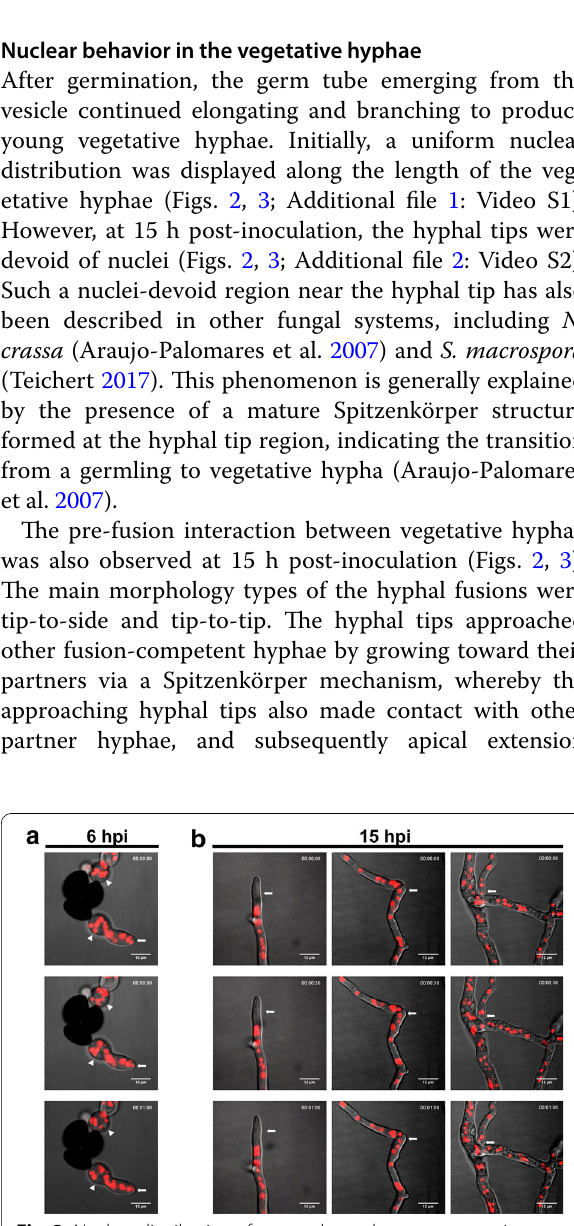
Fig. 3 Nuclear distribution of germ tube and mature vegetative hyphal tip and representative hyphal fusion events. The ascospores of the H2B‑mCherry‑labeled strain were grown on malt extract agar III under uniform constant white light. a Nuclear florescence was evenly distributed throughout the germ tube at 6 h post‑inoculation (hpi). b At 15 hpi, the nuclei in the elongated vegetative hyphae (left) were absent in the tip regions, whereas nuclei were detected in the apical regions of pre‑fusion hyphae [either tip‑to‑tip (middle) or tip‑to‑side (right)]. Live images were captured with the Deltavision core system. White arrows indicate differentiated sites of nuclear distribution among these fungal structures. White arrowheads indicate germination vesicles. Scale bars represent 12